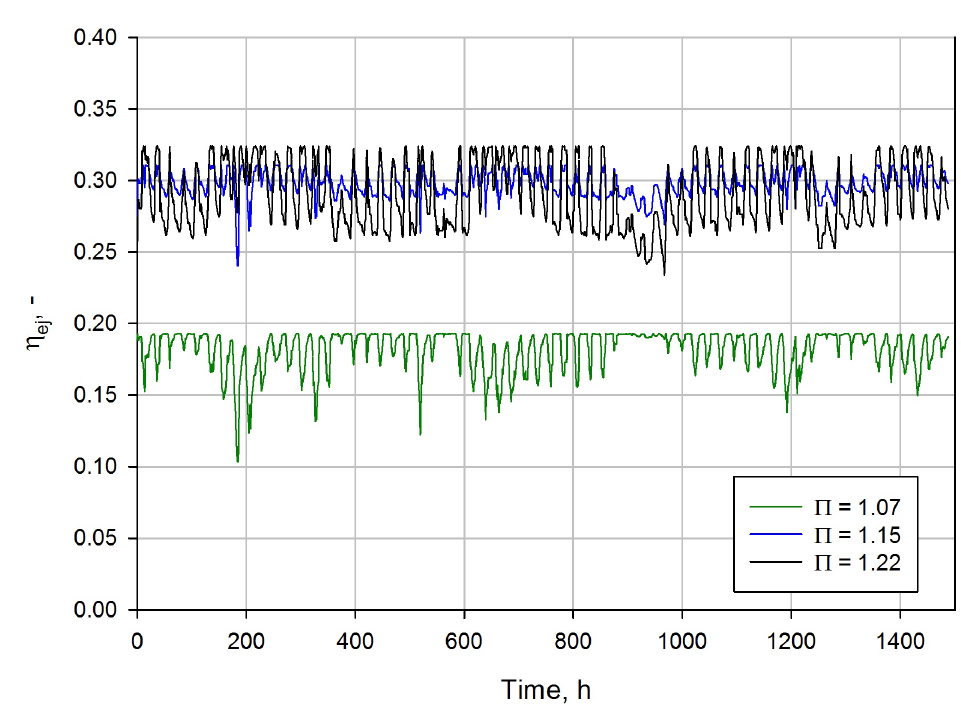
Figure 10. The ejector efficiency at different pressure ratios during the summer campaign in the South America